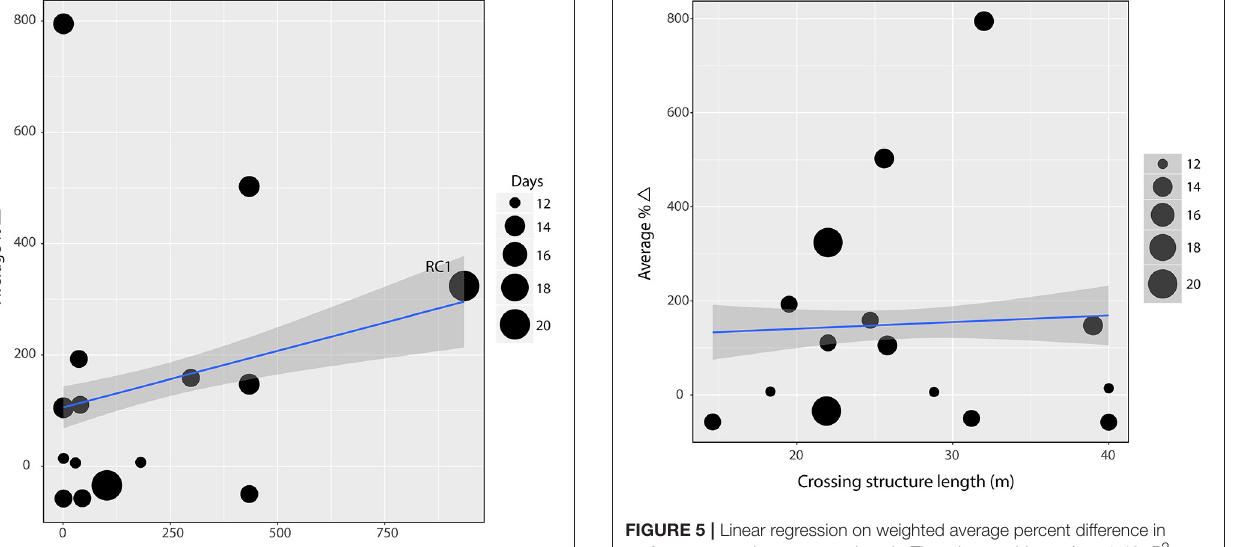
FIGURE 5 | Linear regression on weighted average percent difference in performance against structure length. There is no evidence ( β = 1.42, R 2 = 0.002, p = 0.50) that the length (in meters) of a structure associates with performance. Gray band indicates 95% confidence interval and point size indicates number of days of observation at the